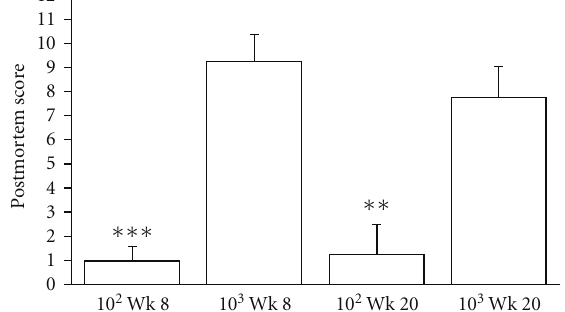
Figure 1: The mean postmortem scores for each group of ferrets infected with either 0 . 8 × 10 2 or 1 . 1 × 10 3 CFU M. bovis and examined postmortem at either 8 or 20 weeks post infection. Di ff erences between the 10 2 and 10 3 CFU infection groups at 8 weeks post infection were significant at the P < . 001 level, while di ff erences at week 20 post infection were significant at the P < . 01